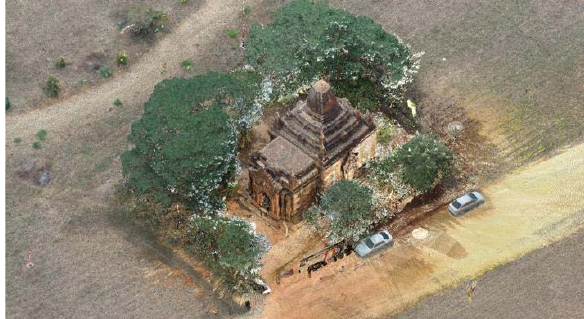
Figure 9. Screenshot of a dense point cloud of Loka-Hteik-Pan temple in Bagan, Myanmar, taken in Autodesk Recap Figure 8. Screen capture of set of 3D laser scans being registered in Faro SCENE The point clouds obtained from processing the SCENE were exported to Autodesk ReCap (Autodesk Inc., 2018) to allow the consolidation of point clouds obtained from both photogrammetry and 3D laser scanning (Figure 9). After consolidation, the point clouds were exported as .e57 files.